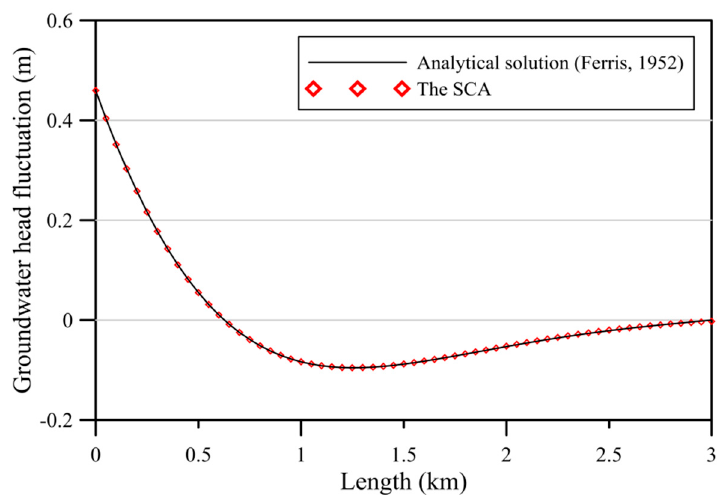
Figure 11. Comparison of the computed head fluctuation with the analytical solution.